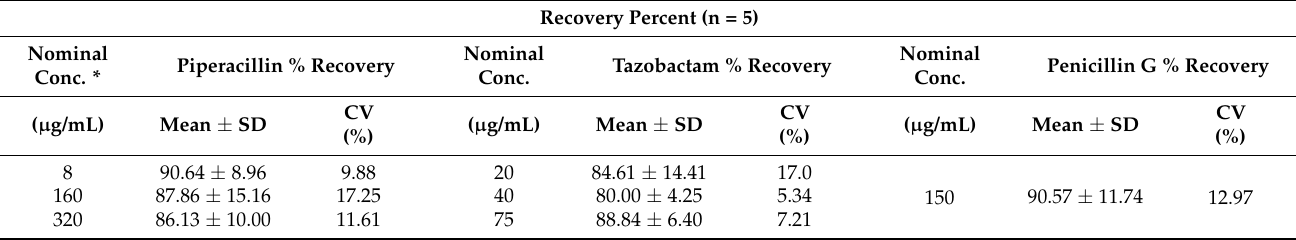
Table 2. Extraction recovery for piperacillin, tazobactam and penicillin G.